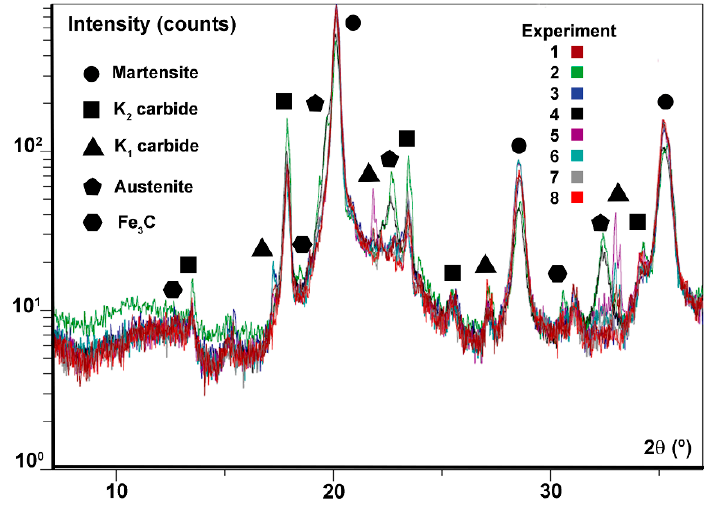
Figure 4. Superimposed diffractograms obtained in the eight experiments.